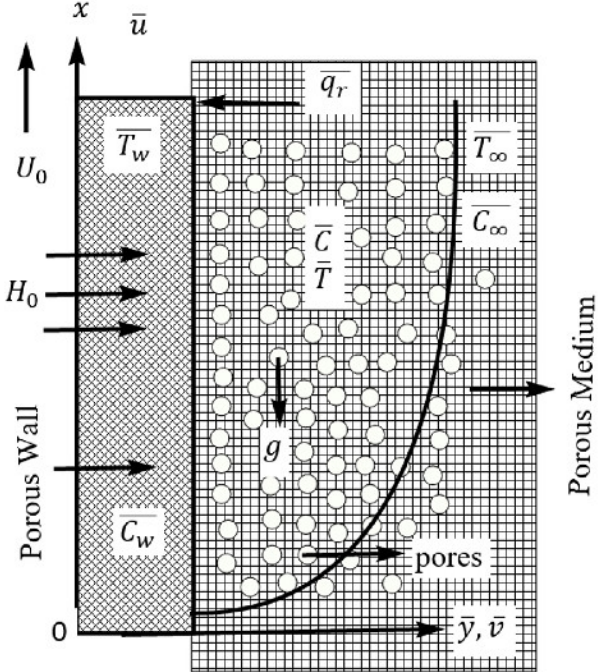
Figure 1. Geometry of the mathematical problem.